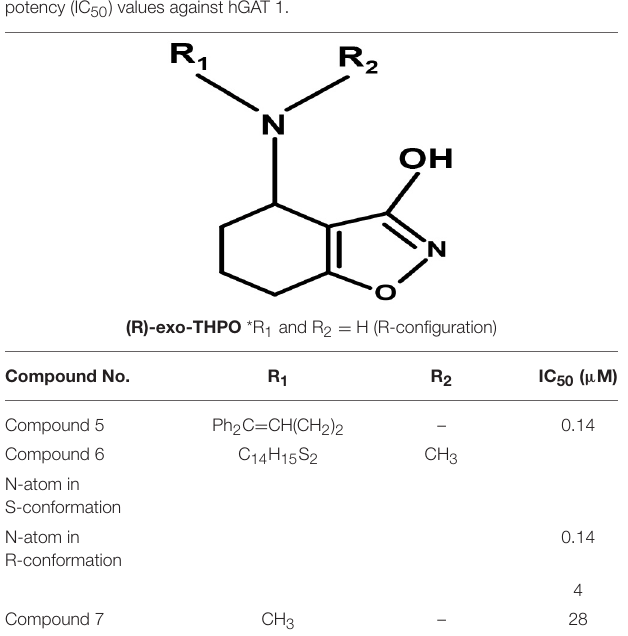
FIGURE 10 | Chemical structures of GATs inhibitors having ability to cross BBB due to attachment of the linker lipophilic chain.